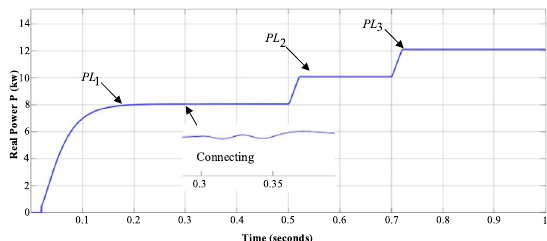
Fig. 10 Active power dynamics response at PCC